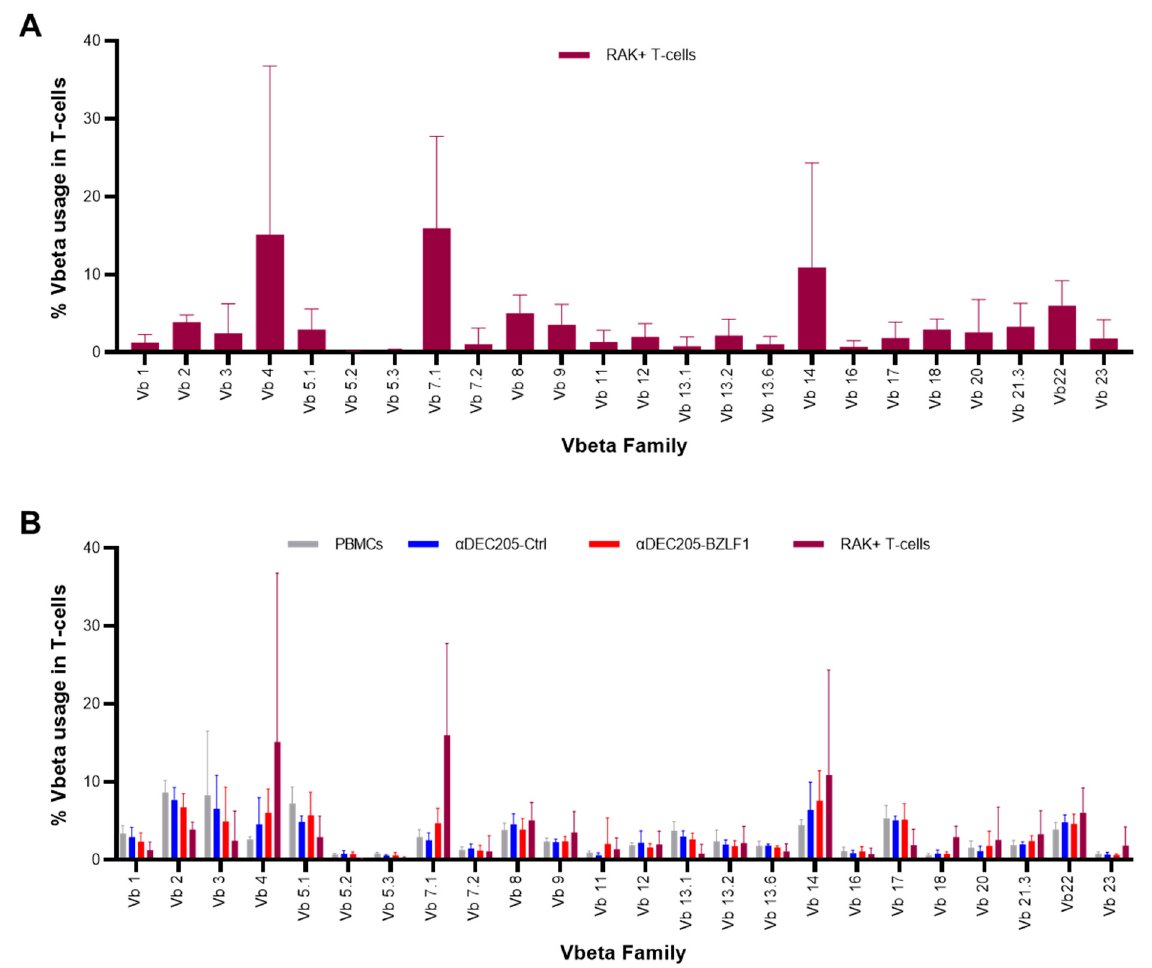
Figure 5. TCR clonogram: ( A ) TCR clonogram of V β repertoire in RAK+ T-cells across 4 HLA-B8 donors; ( B ) Comparison of the TCR-V β repertoire between PBMCs, α DEC205-Ctrl CoCx, α DEC205-BZLF CoCx, and RAK+ T-cells across 4 HLA- B8 donors.